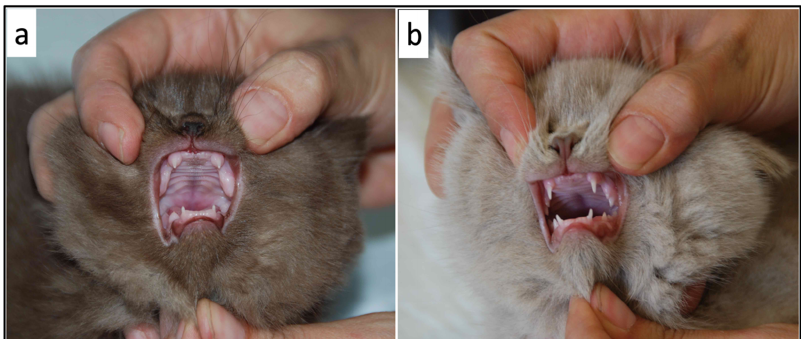
Figure 2. Comparison of tooth eruption between two siblings ( a ) Delayed tooth eruption in one of the 3 kittens with growth failure ( b ) Normal tooth eruption in one of the healthy littermates.